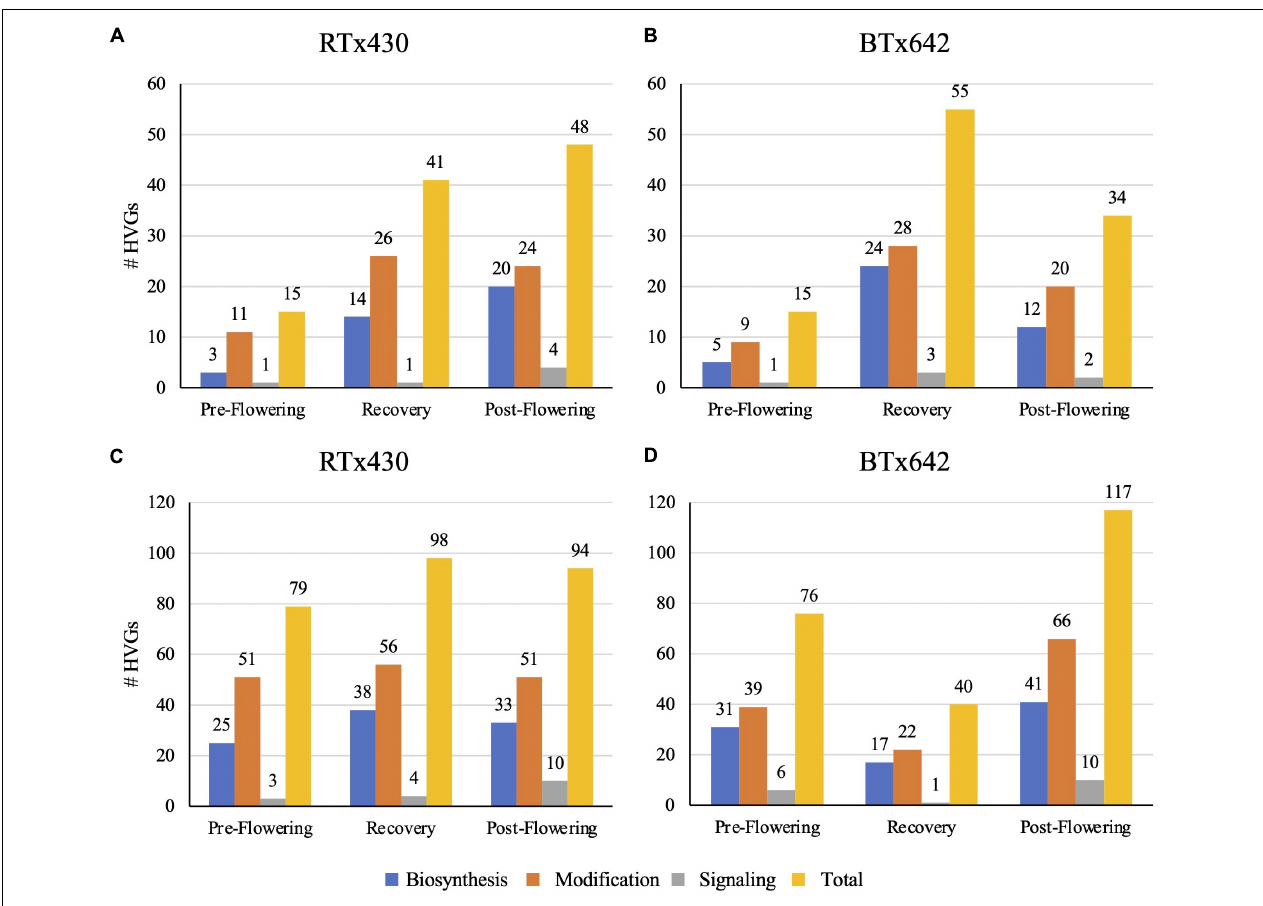
FIGURE 1 | Total number of highly variable genes (HVGs) with cell wall-related gene ontology (GO) terms in leaves (A,B) and roots (C,D) . Highly variable genes are those genes in the top 10% of differentially expressed genes in response to drought conditions, of the HVGs, those genes with cell wall-related GO terms were analyzed and classed via putative functions related to biosynthesis, modification, and signaling of the cell